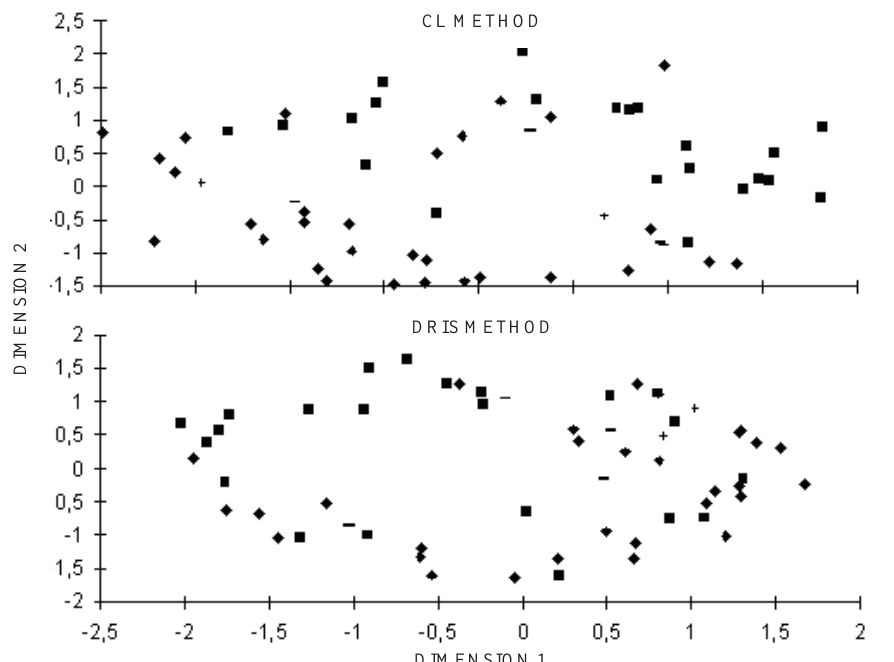
Figure 2. Scatterplot of bidimensional space analysis of Euclidean distances between coffee plantations based on the nutritional status evaluated by Critical Level method (CL method) or DRIS method. (LA: Yellow Latossol, ; LV: Red Latossol, +; LVA: Red-Yellow Latossol, ¤¤¤¤¤ , PVA: Red-Yellow Argissol, Table 3. Scaling solutions for the nutritional status of coffee crops by the multidimensional scaling analysis, based on Euclidean distances, determined by the Critical Level method (CL) or by the DRIS method (DRIS)